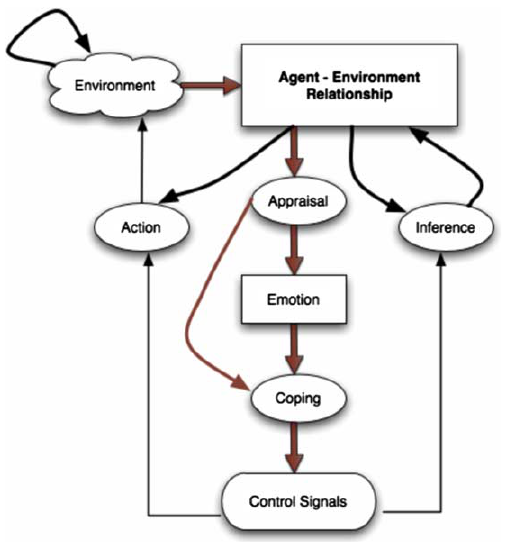
Figure 2. Theoretical assumptions of the relationship between appraisal, emotion, coping and cognition, and the sources of dynamics (Marsella and Gratch